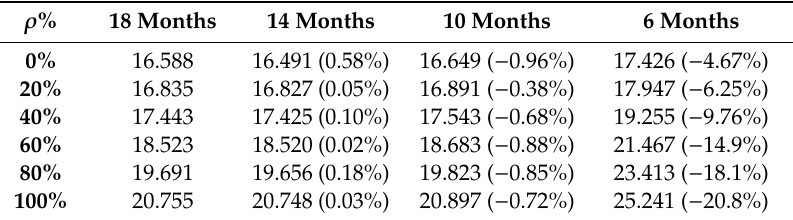
Table 2. Average RMSE of three deterministic forecasting models trained by di ff erent numbers of training